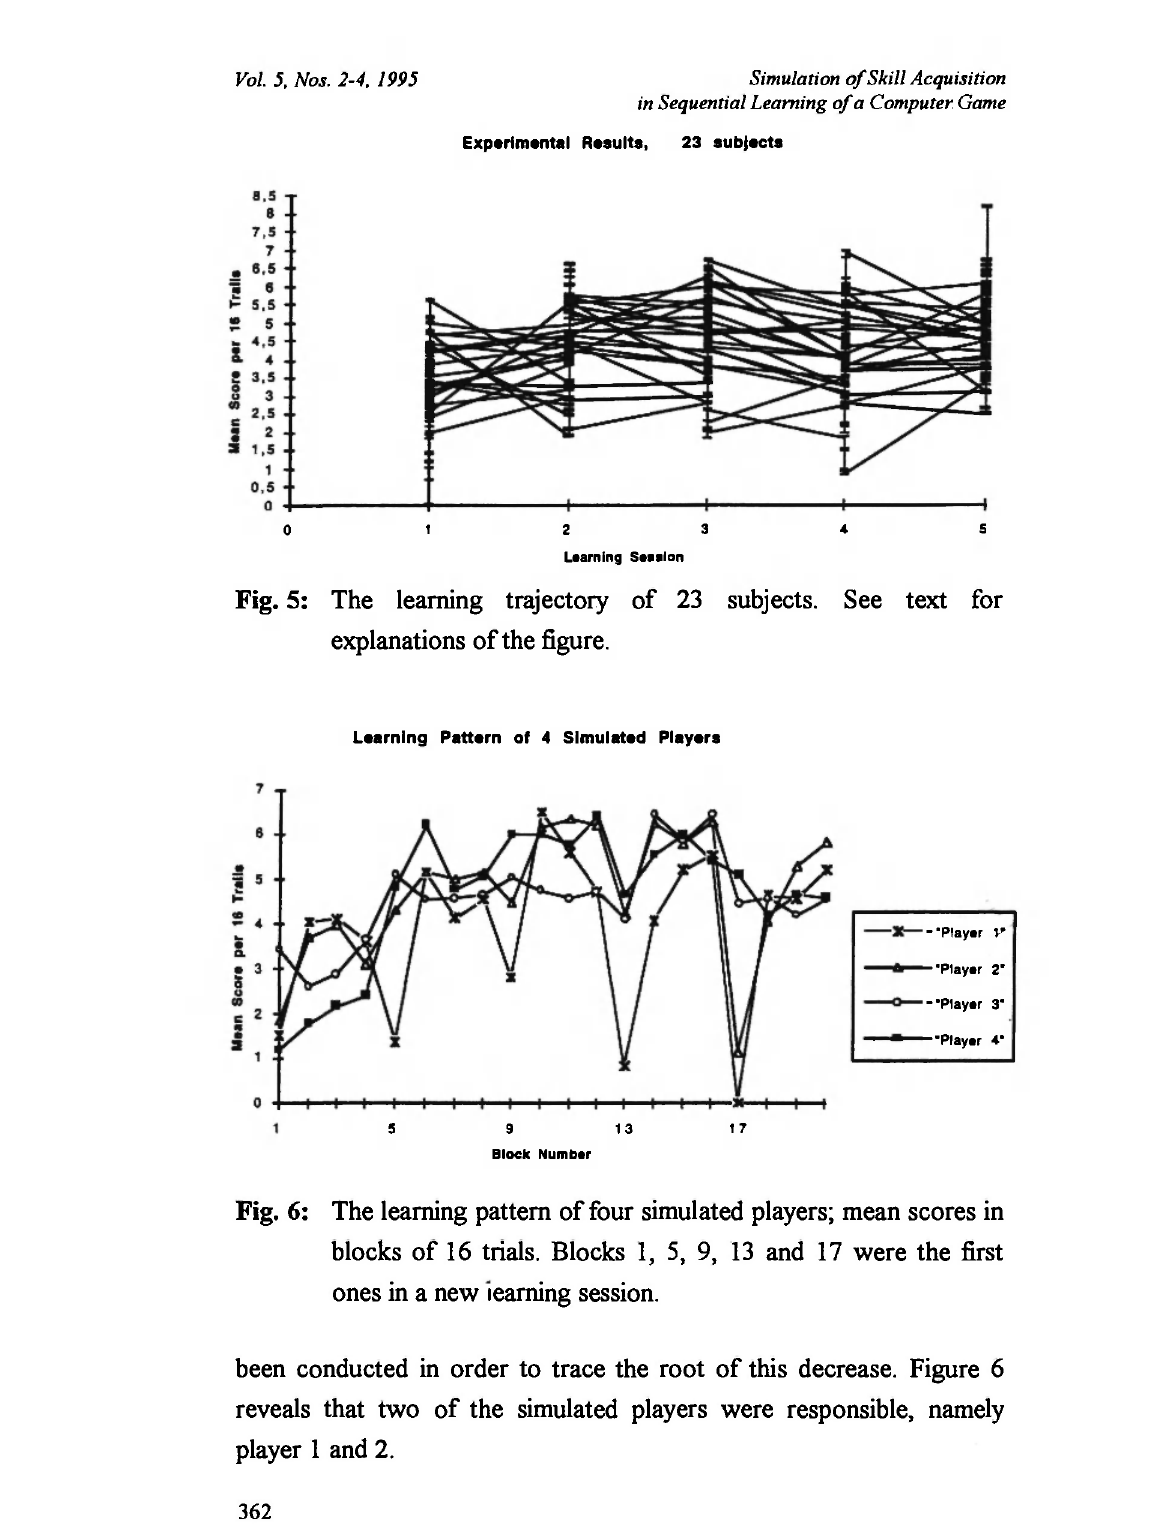
Fig. 6: The learning pattern of four simulated players; mean scores in blocks of 16 trials. Blocks 1, 5, 9, 13 and 17 were the first ones in a new learning